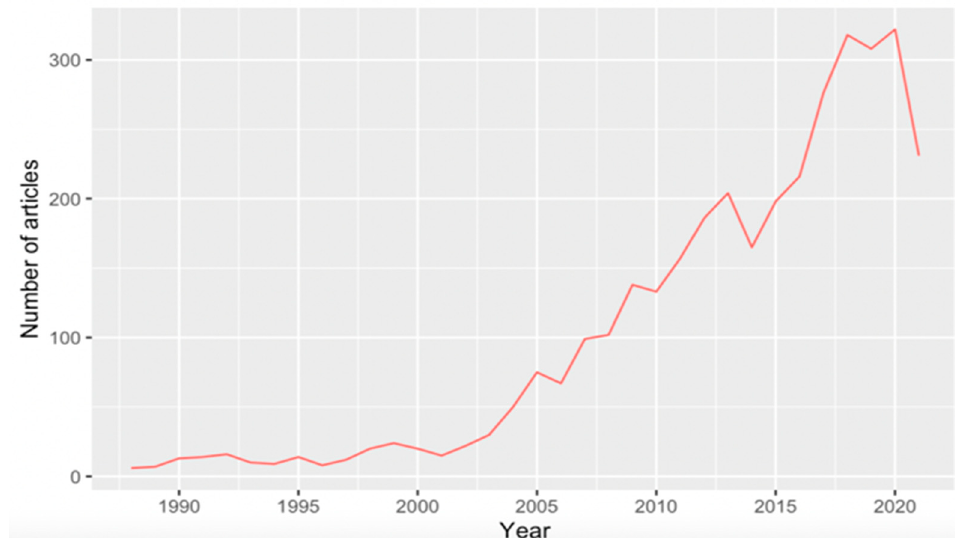
Table 3. Research trends by period.